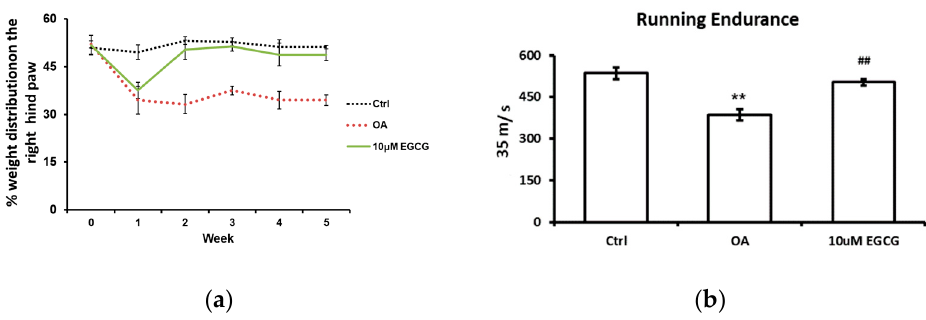
Figure 1. The anti-allodynic effect of EGCG. ( a ) The temporal pattern of weight distribution of the osteoarthritis (OA) joint. Rats injected with 10 μ M EGCG (EGCG group) or saline (OA group and control group) in the right knee were examined for the change in hind paw weight distribution for 5 weeks after anterior cruciate ligament transection (ACLT). A significant difference was noted between OA and EGCG-treated groups at 2, 3, 4, and 5 weeks after ACLT. ( b ) The results of running endurance at 5 weeks after ACLT. The running endurance was tested one week before and every one week after ACLT for 5 weeks. The running endurance was significantly decreased in the OA group compared with the control. There was a significant improvement in running endurance after EGCG treatment. (** p < 0.01 OA vs. control; ## p < 0.01 OA vs. EGCG).